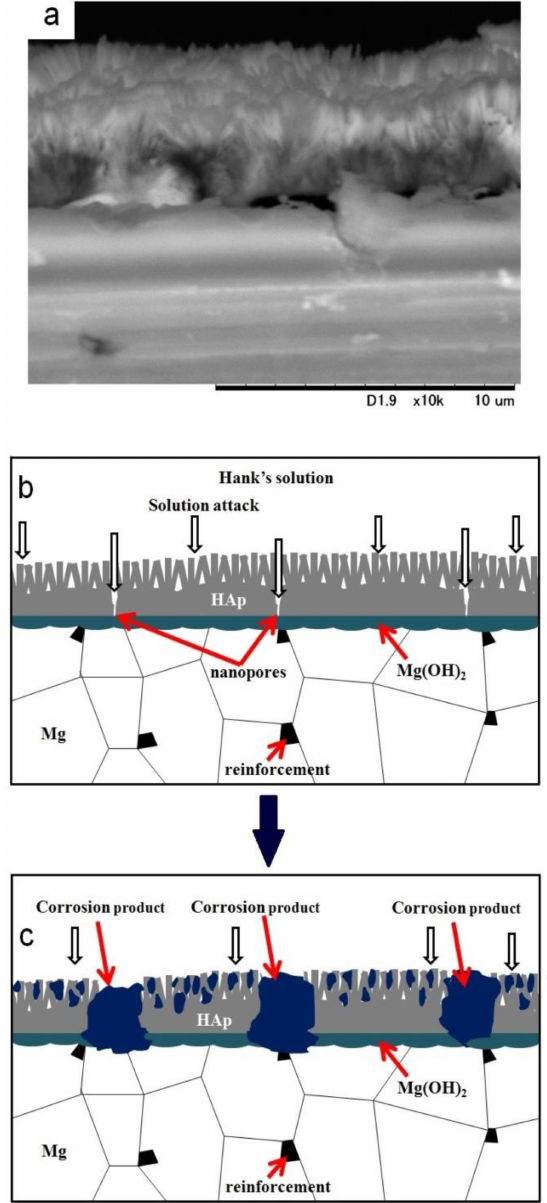
Figure 10. SEM image of the cross-section of a HAp-coated Mg-10ZnO-2.5 h + 10 min sample ( a ) and illustration of the corrosion process of the HAp-coated composites ( b ) and ( c